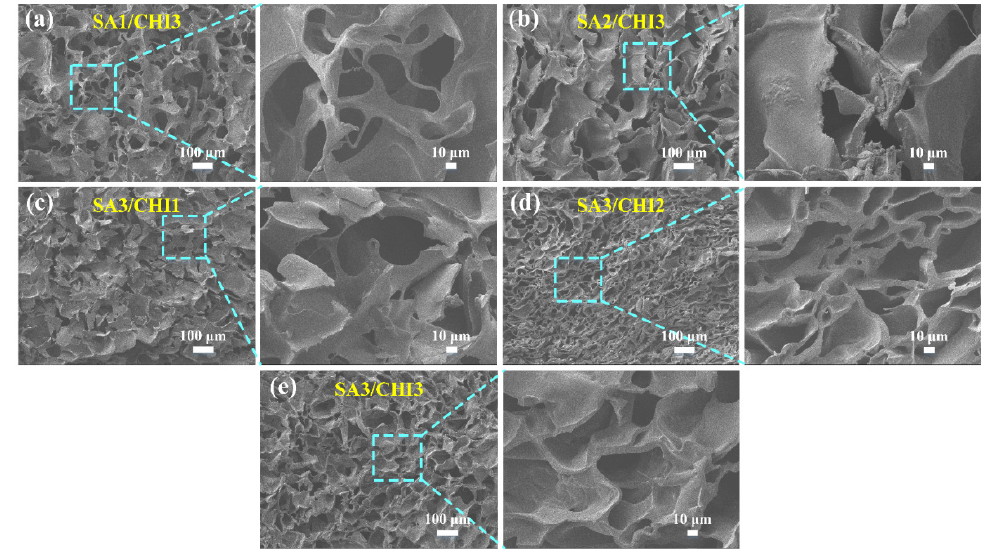
Figure 4. Cross-sectional views of different SA/CHI porous sponges in different magnifications. ( a ) SA1/CHI3. ( b ) SA2/CHI3. ( c ) SA3/CHI1. ( d ) SA3/CHI2. ( e ) SA3/CHI3.